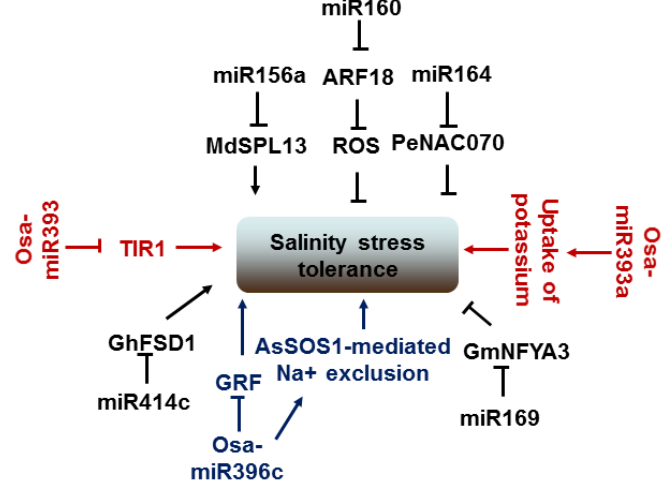
Figure 7. Pathway of miRNAs involved in salinity stress response. MiR156- SPL13 , miR160- ARF18 , miR164- NAC070 , miR169- NFYA3 , and miR414c- FSD1 modules regulate plant salinity stress tolerance. MiR393 and miR396c can positively or negatively regulate salinity stress response of plant through different pathways.